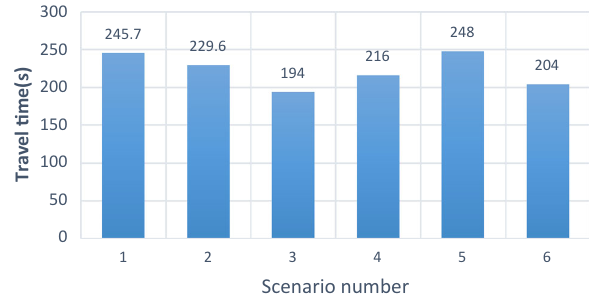
Fig. 7 Travel time in each